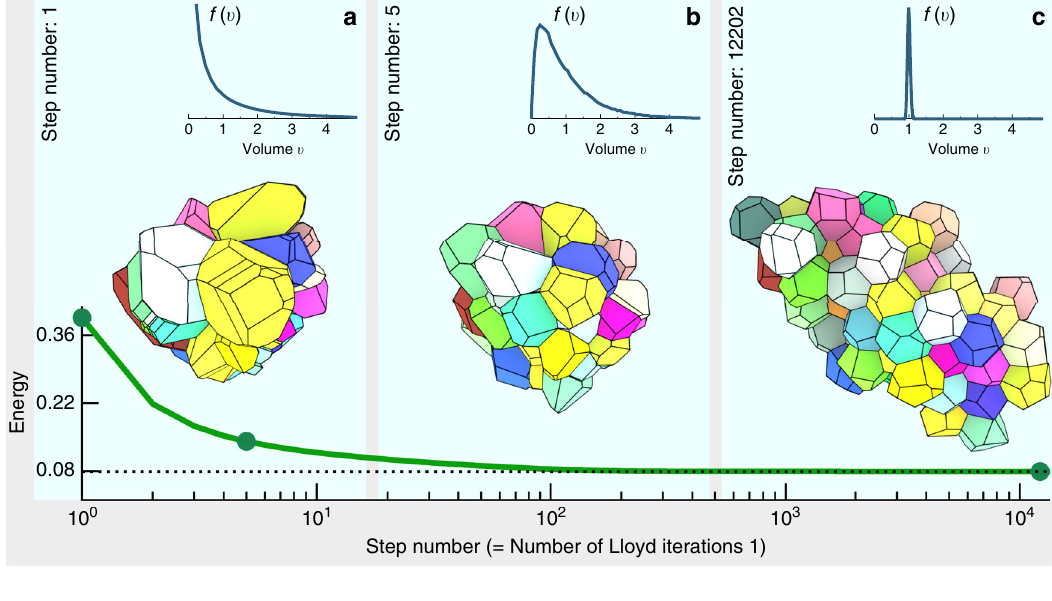
Fig. 2 Convergence of Lloyd ’ s algorithm in 3D. Shown is a subset of a 3D system at step number N = 1 (initial tessellation), N = 5, and N = 12202 ( fi nal tessellation); see also the Supplementary Movie 1. The initial con fi guration is a 3D hyper fl uctuating point set. The distributions f ( v ) of cell volumes v demonstrate the high degree of uniformity in cell volumes in the fi nal states. The dimensionless total energy converges to a value 〈 e t 〉 ≈ 1.008 × e BCC slightly above the value e BCC = 0.07854 of the optimal BCC